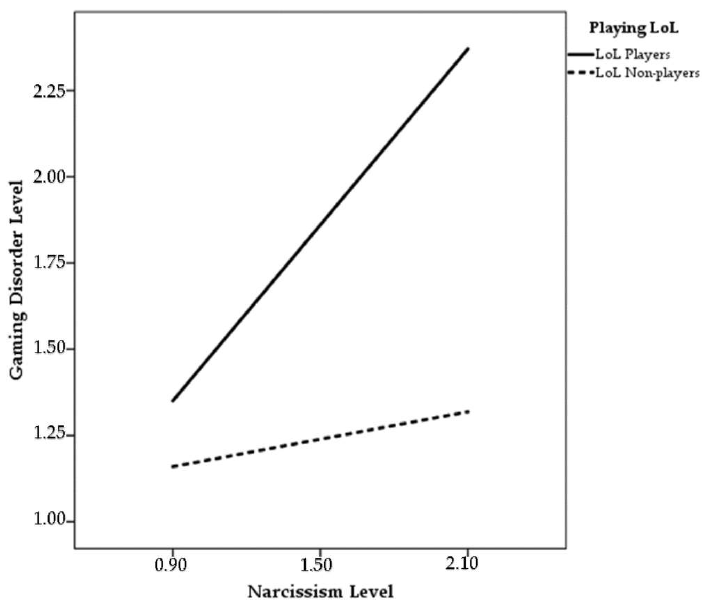
Figure 2. Moderation of Playing LoL on gaming disorder and narcissism.